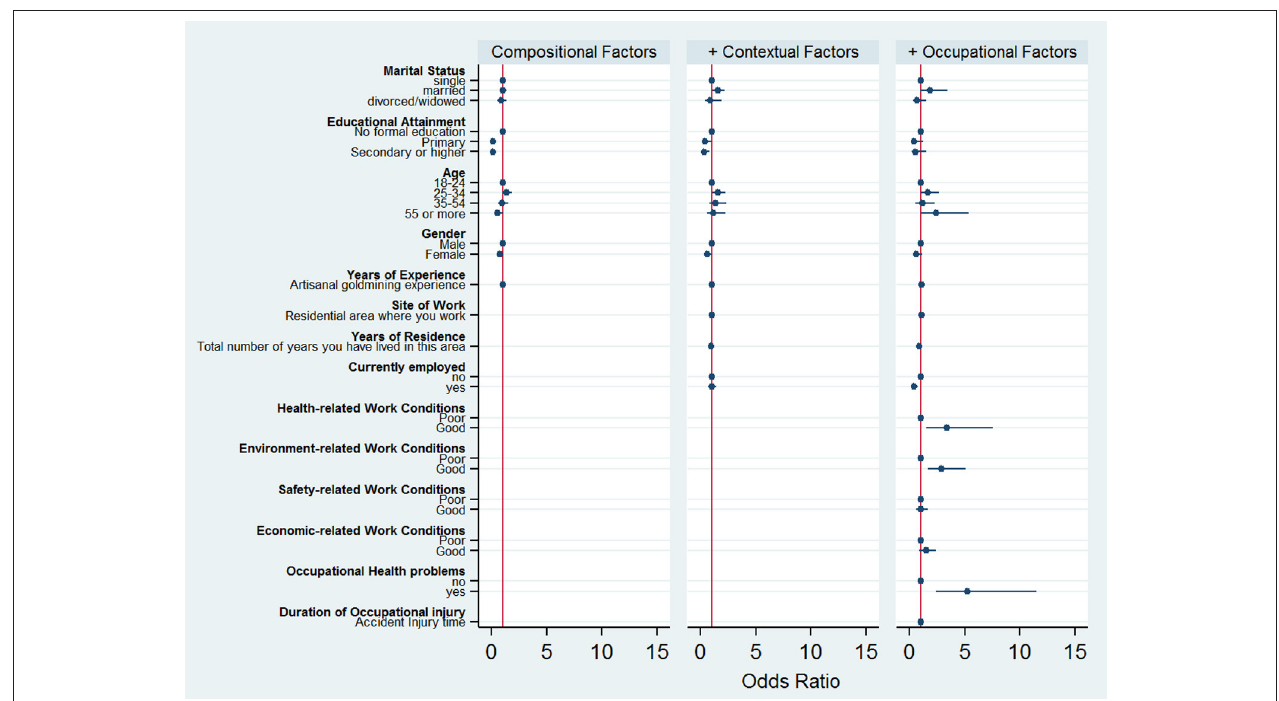
FIGURE 2 | Graphical representation of the multivariate relationships between artisanal gold miners’ knowledge of health effects of mercury and theoretically-relevant